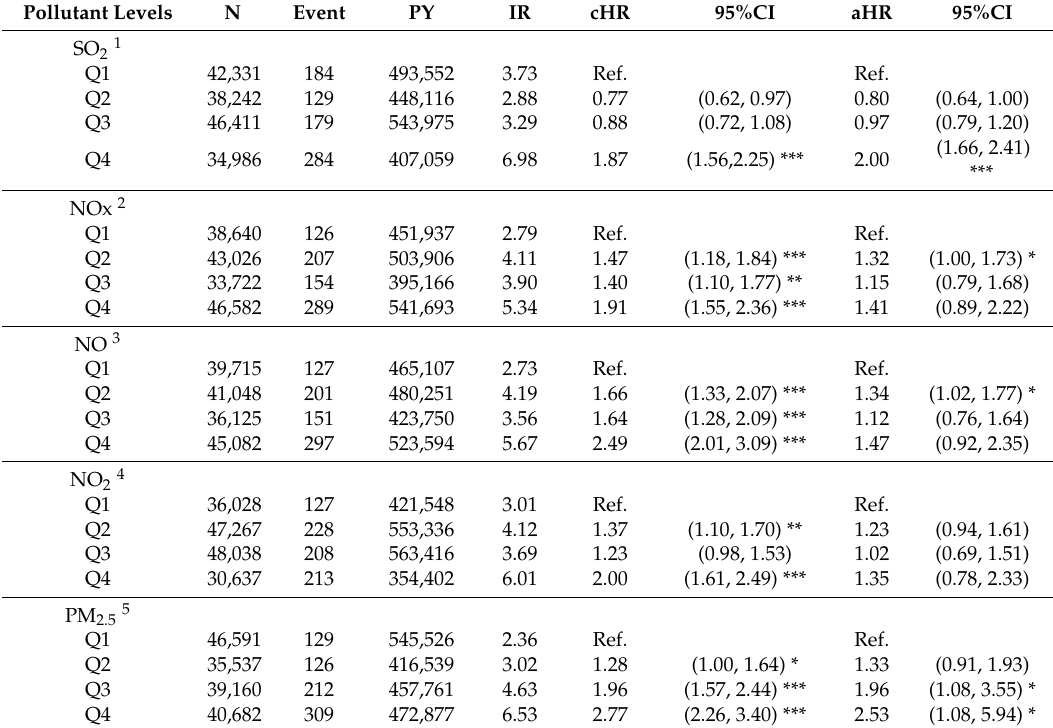
Table 3. Differences in nephrotic syndrome incidences and associated HRs in participants exposed to various daily average concentrations of air pollutants.